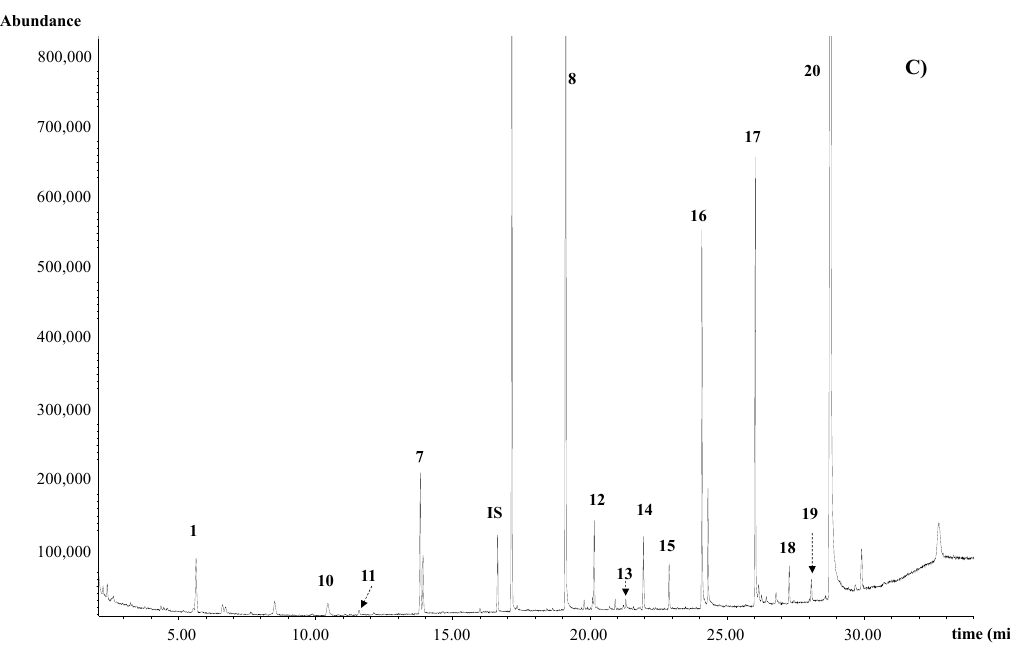
Figure 1. GC-MS profile of alfalfa SLE extracts previously derivatized to TMS-Oximes. ( A ) Leaves (Lv2); ( B ) Stems (St2); ( C ) Seeds (Sd2): 1: pinitol; 2: fructose 1; 3: fructose 2; 4: ononitol 5: glucose E ; 6: glucose Z ; 7: myo -inositol; 8: sucrose; 9: trehalose; 10: galactose E ; 11: galactose Z ; 12: galactosyl-pinitol A; 13: galactosyl-pinitol B; 14: galactinol; 15: digalactosyl- glycerol, 16: raffinose; 17–19: digalactosyl-inositol; 20: stachyose; IS: internal standard.